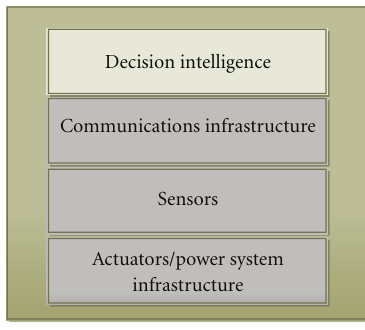
Figure 1: Smart grid